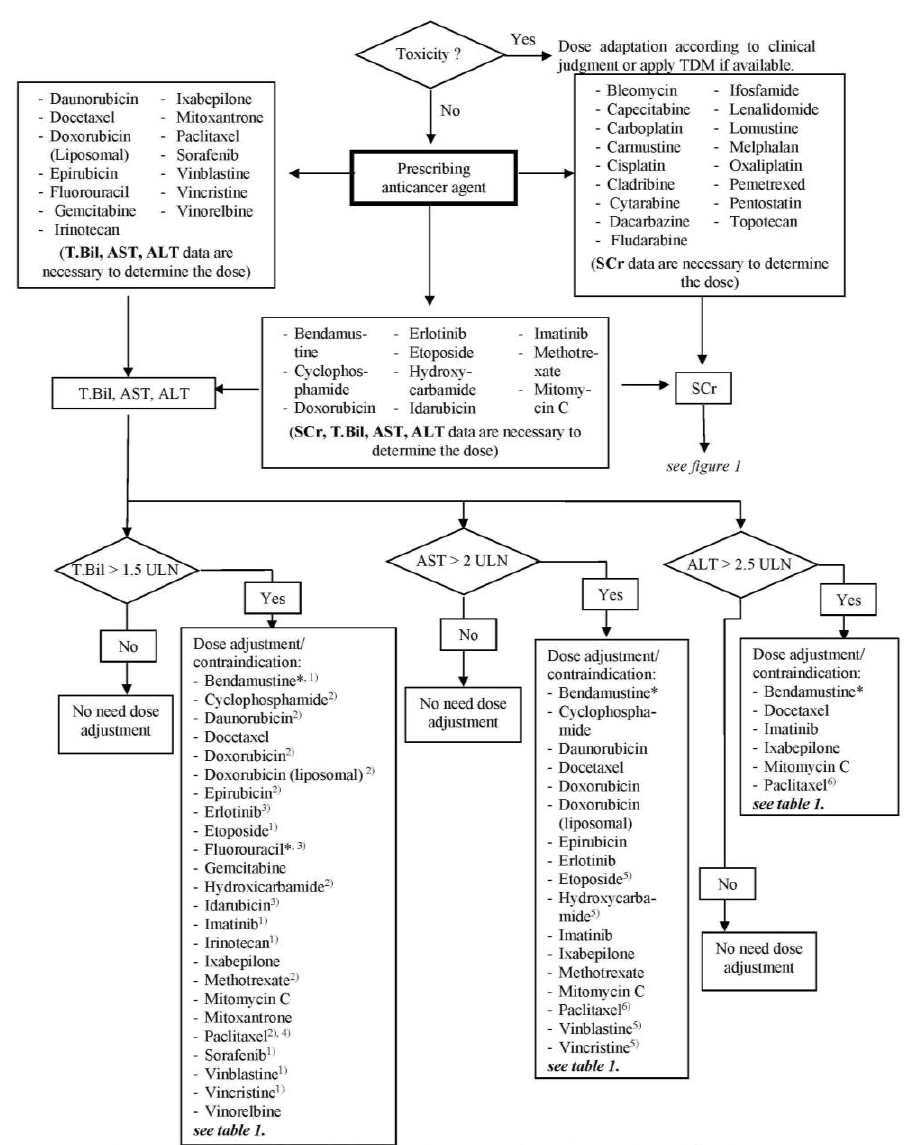
Figure 2. Algorithm of dose adjustment of anticancer agents for a patient with hepatic dysfunction.